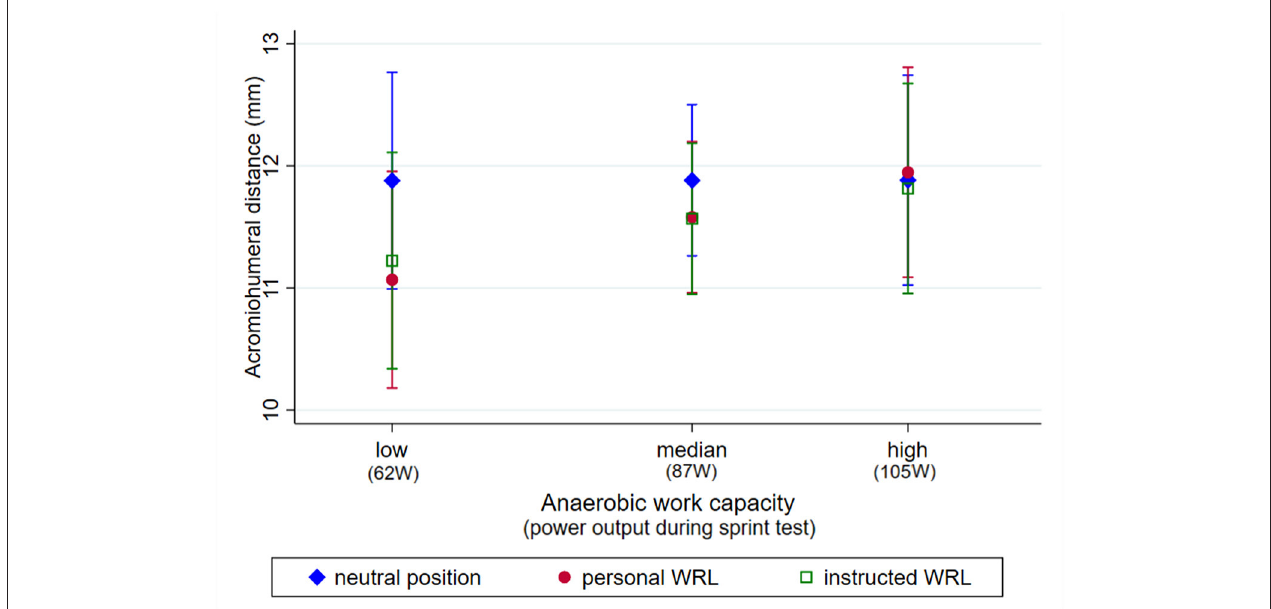
FIGURE 3 | Predictive margins with 95% confidence interval of acromiohumeral distance (AHD, mm) measured during different loading positions (unloaded position, personal WRL, and instructed WRL) in participants with a low (62W, 25% percentile), median (87%) and high (105, 25% percentile) anaerobic work capacity.